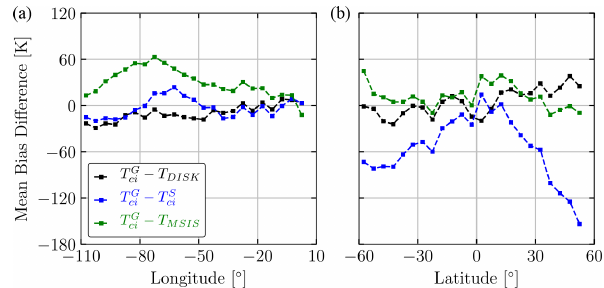
Figure 8. Mean bias difference (MBD) of T G and T ci s for 5 ◦ bins as a function of longitude (a) and latitude (b) during 2–8 November 2018 at 15:00UT. All longitudes viewed by GOLD are considered when computing MBD as a function of lat- itude, and only equatorial latitudes between ± 10 ◦ are considered when computing MBD as a function of longitude.